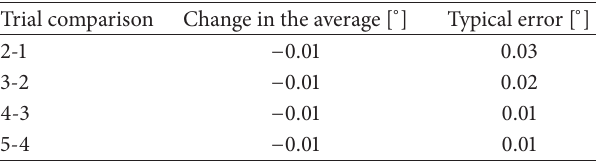
Table 3: Comparing the single measurement trials to each other. Trial